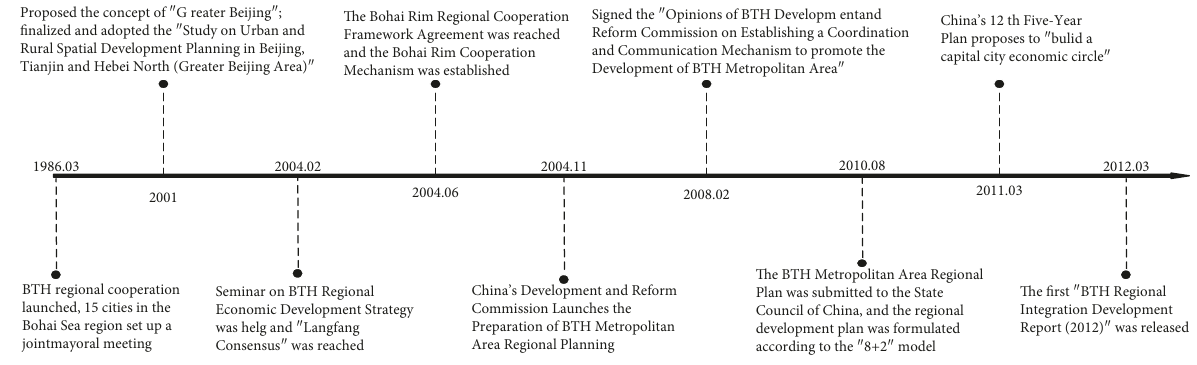
Figure 2: History of BTH synergistic development (before